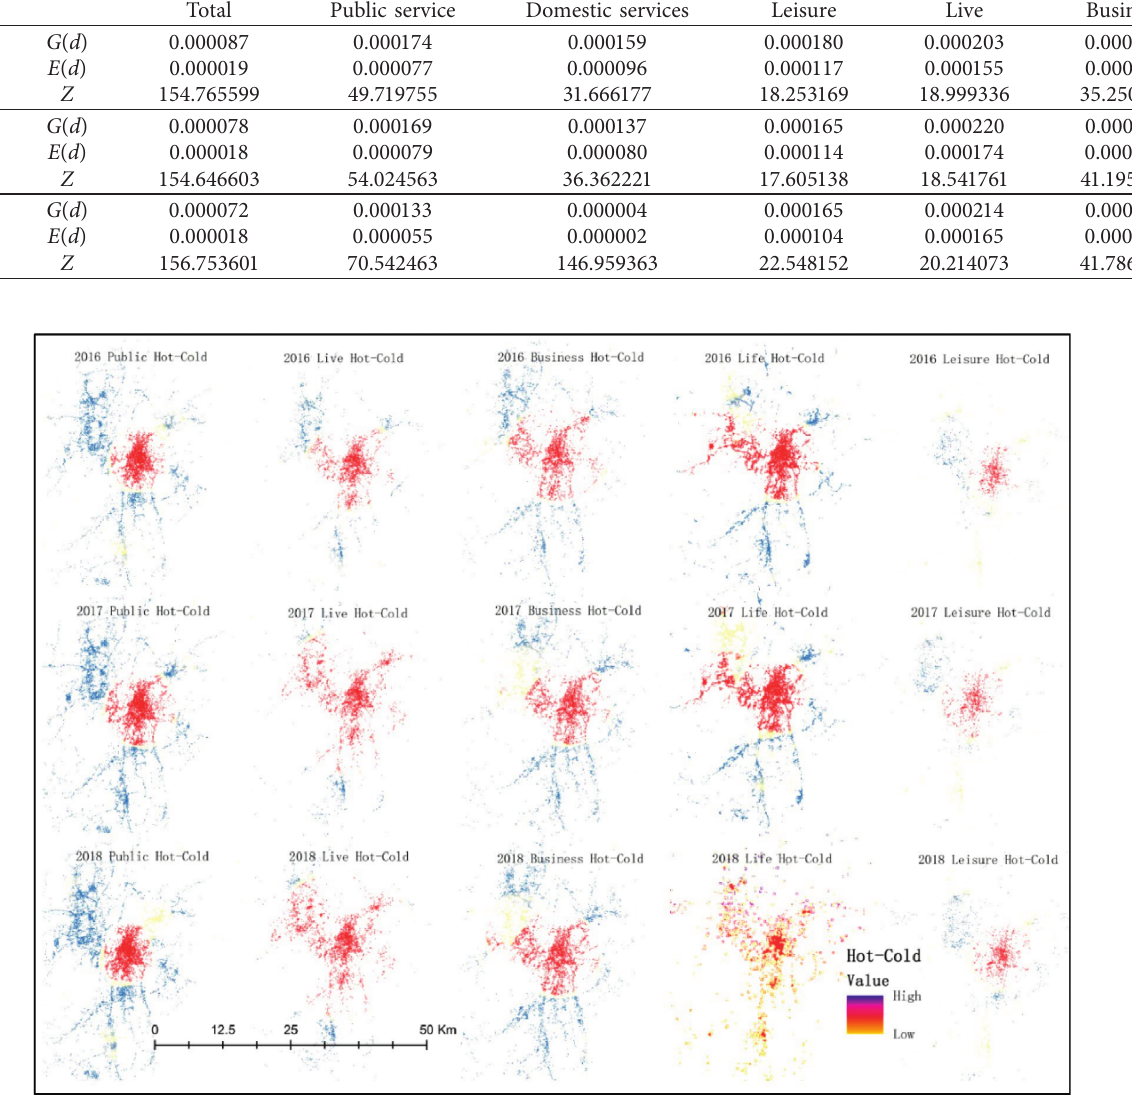
Figure 4: The evolution of the “hot spot” in the main urban area of Guiyang from 2016 to